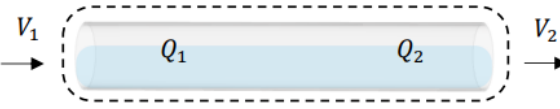
Figure 4. Schematic of pipeline and parameters.